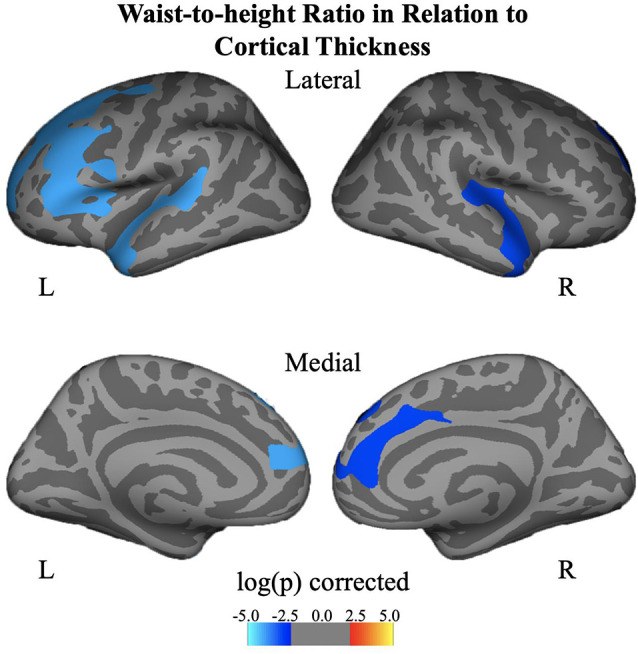
Associations between waist-to-height ratio and cortical thickness, controlling for age and sex and corrected for multiple comparisons at p < 0.05.